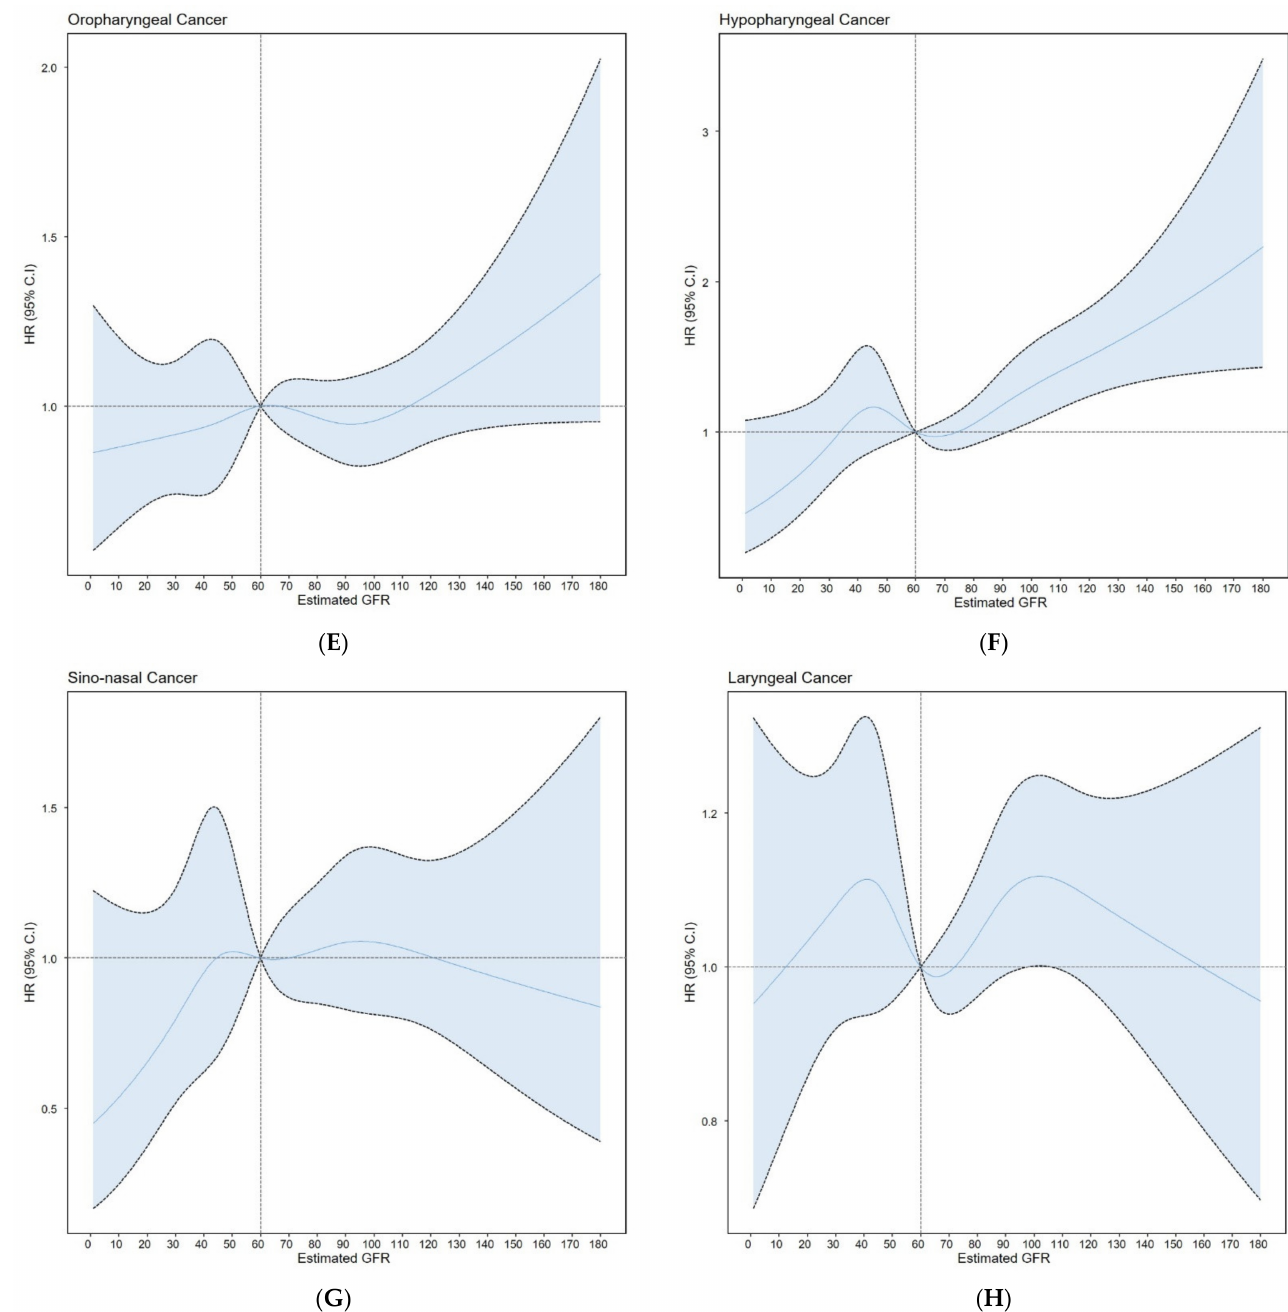
Figure 1. A restricted cubic spline showed the relationship between the estimated glomerular filtration rate and subtypes of head and neck cancer: ( A ) All head-and-neck cancers; ( B ) oral cancer, ( C ) salivary gland cancer, ( D ) nasopharyngeal cancer, ( E ) oropharyngeal cancer, ( F ) hypopharyngeal cancer, ( G ) sinonasal cancer, and ( H ) laryngeal